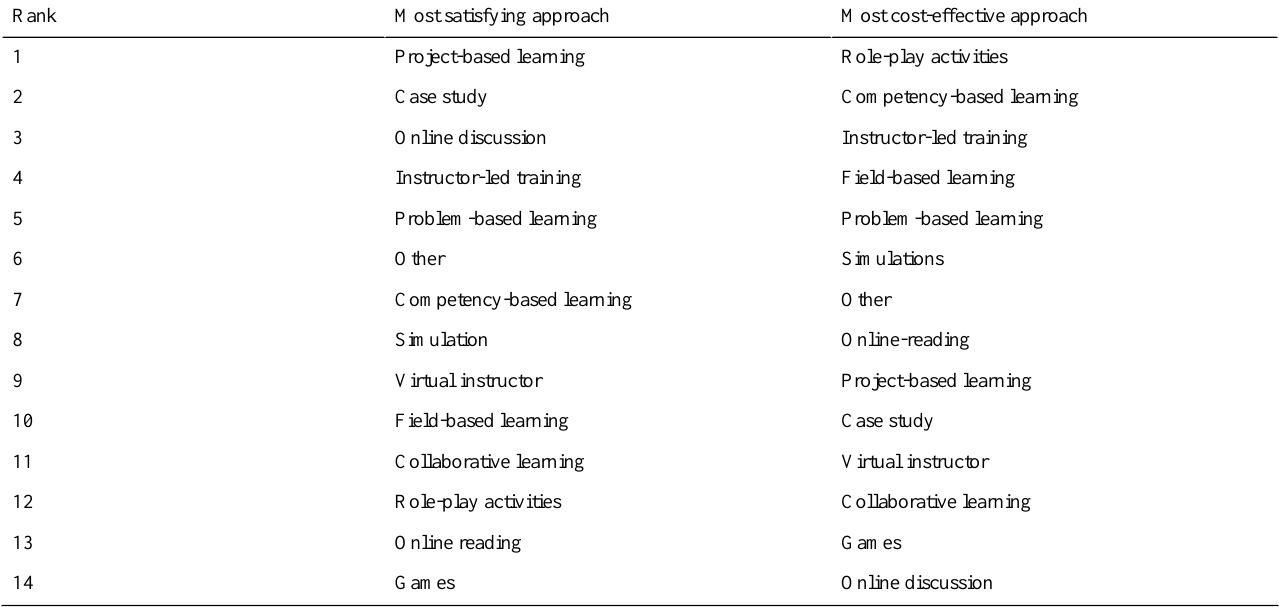
Table 4. Comparison between the most satisfying and most cost-effective approaches.